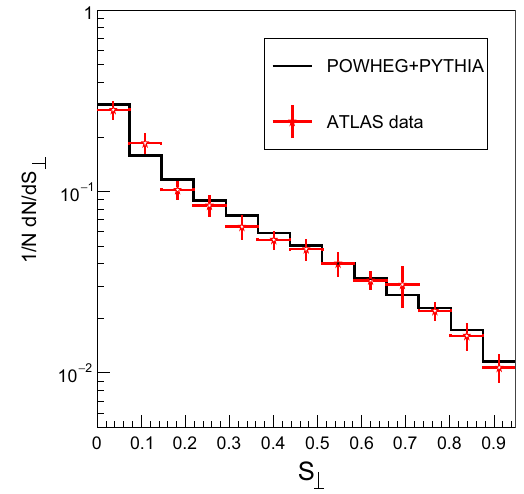
Fig. 2 Event number normalized distribution of transverse sphericity √ s = 7 TeV form POWHEG+PYTHIA calcula- in p+p collisions at tion compared with ATLAS